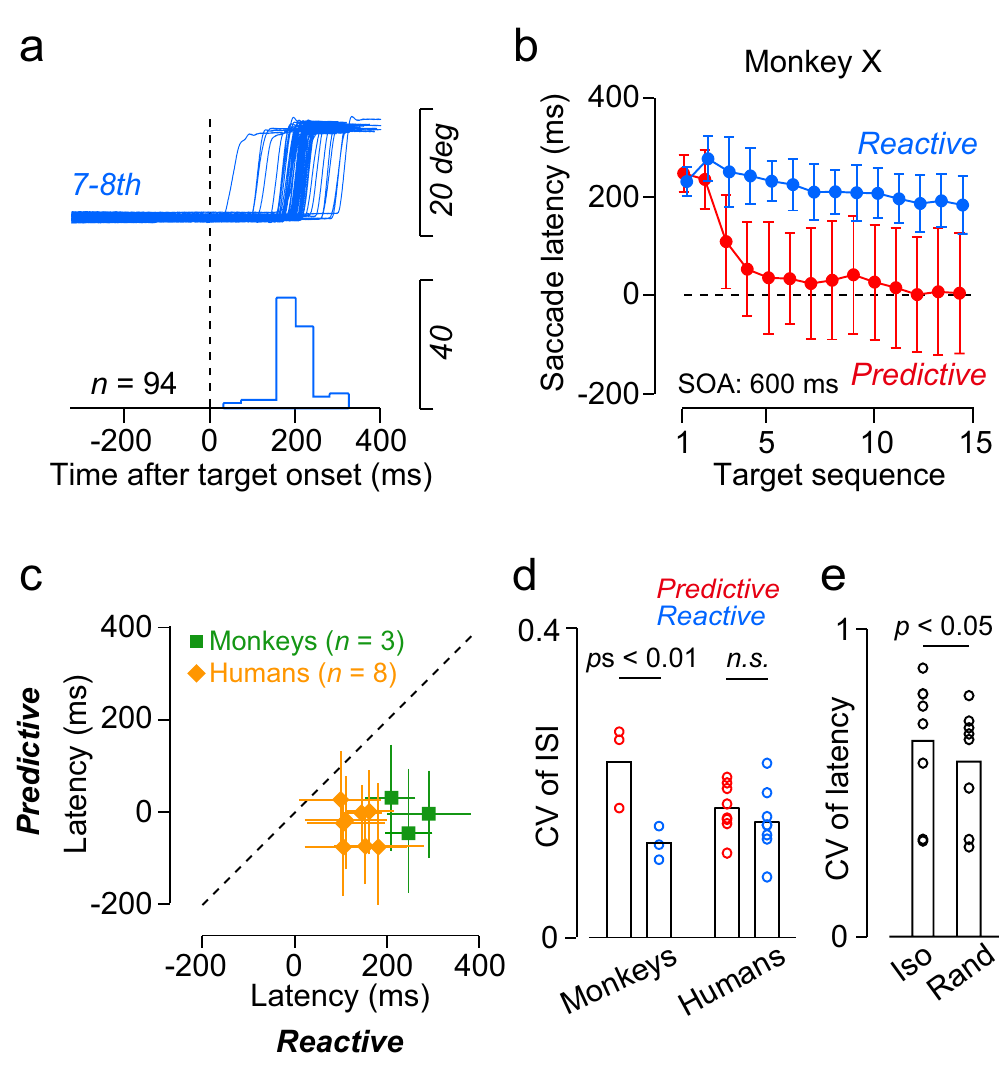
Figure 5. Flexible switching of behavioural strategy. ( a ) Data from a single experimental session in the reactive condition for monkey K. Traces of eye position are aligned on the 7–8th target onset (vertical dashed line) in trials with a 600-ms SOA. The animal was rewarded for every reactive saccade (Fig. 1c, see Methods). ( b ) Means ( ± SDs) of saccade latencies as a function of target sequence in the reactive (blue) and predictive (red) conditions. Data for each condition were obtained from 5 experimental sessions. ( c ) Comparison of the means of the 5–12th saccade latencies between the conditions in trials with a 600-ms SOA. Symbols with different colours indicate different species. Each data point indicates the mean ( ± SD) of individual trials in all experimental sessions for each subject. Note that saccade latency in the reactive condition was shorter for humans than monkeys. ( d ) Comparison of CVs of inter-saccadic intervals (ISIs) measured for different conditions and species. For all cases, CVs were measured for the 4–11th ISIs in the sequence. Each bar indicates the mean of different subjects. ( e ) Comparison of CVs of saccade latencies between the reactive condition with an isochronous stimulus sequence (600-ms SOA) and the random SOA condition for